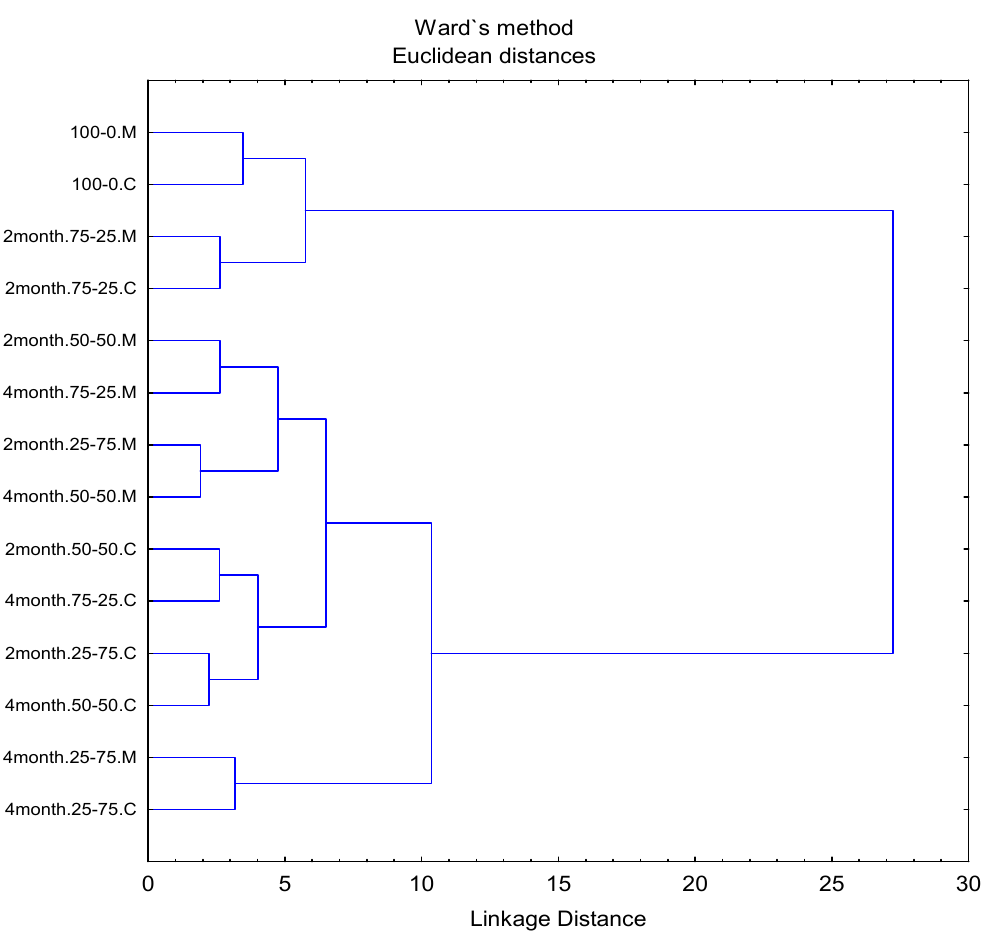
Figure 2. Dendrogram obtained from hierarchical cluster analysis (HCA) of sensory data of Pizza cheeses. M = Microwave cooking, C = Conventional oven cooking, 2 and 4 months = 2 and 4 months ripened Cheddar cheese, 75:25, 50:50, 25:75 = the first part represents Mozzarella and the second part represents Cheddar cheese proportion in Pizza cheeses.